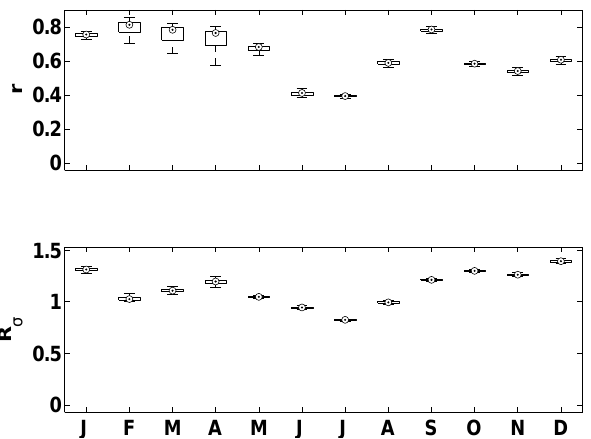
Figure 4. Boxplots of the ESD model parameters: medians (dots) of the downscaling model parameters r (top) and R σ (bottom) esti- mated by cross-validation with AWS1 air temperature as the predic- tands and rea-ens-air as the predictor, for all calendar months. The edges of the boxes are the 25th and the 75th percentiles. The dashes extend to the most extreme data not considered as outliers.